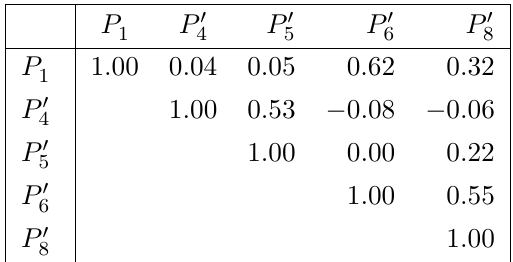
) parameters obtained for q 2 2 [0 : 04 ; 2 : 0] GeV 2 . 0